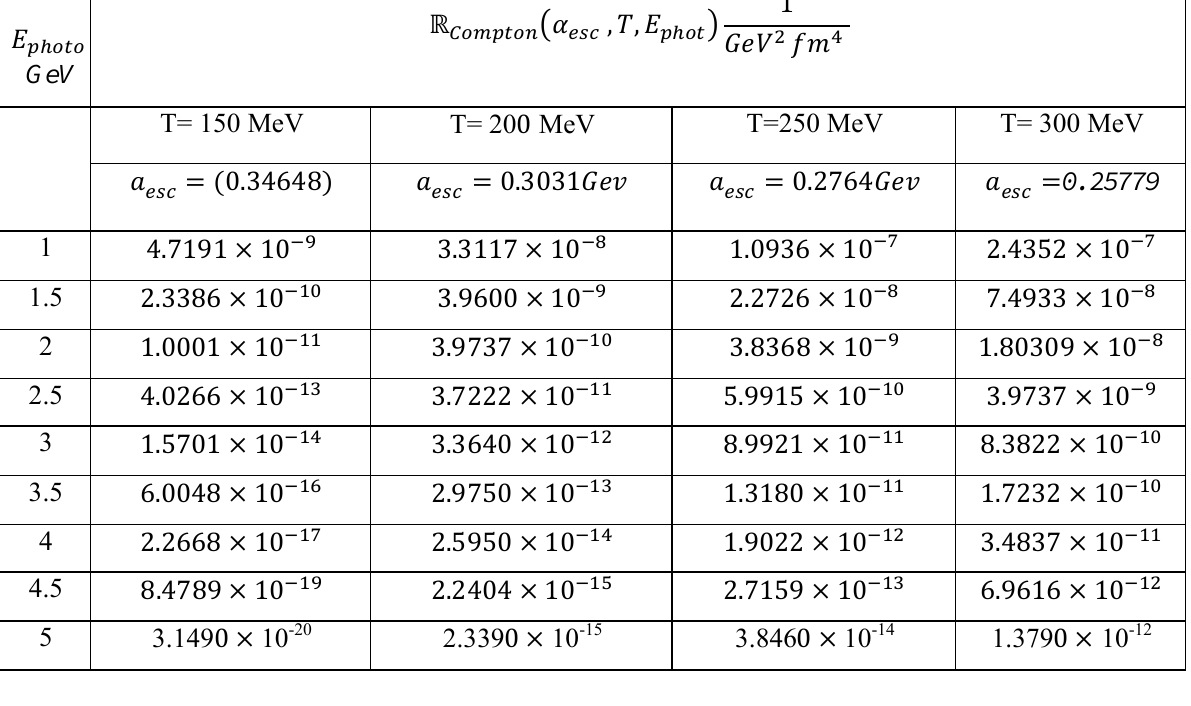
Table 2: The result of photon rate production (cid:1337) at Compton scattering due to (cid:2176) GeV